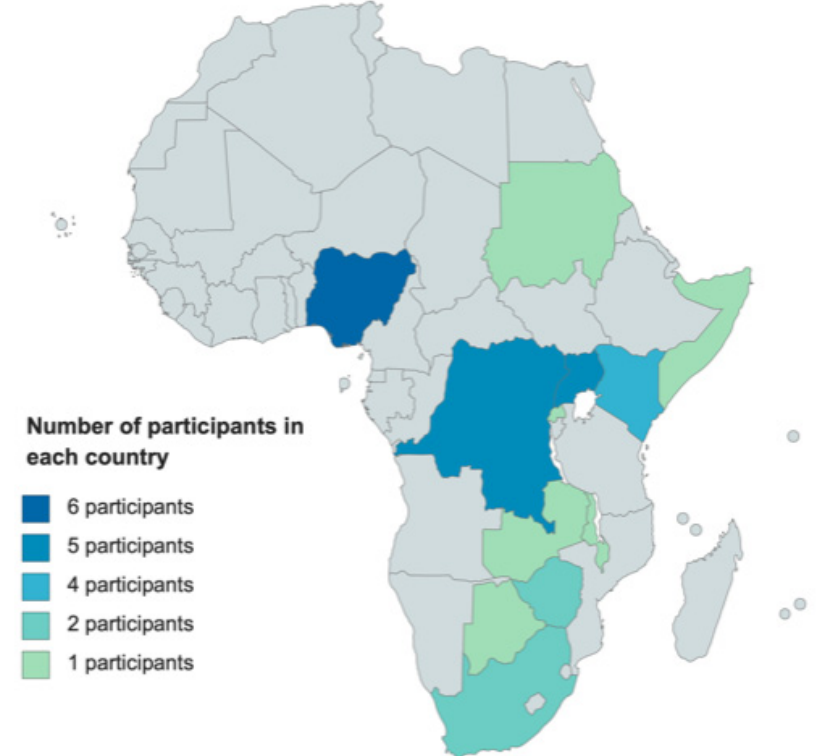
Figure 1. Geographical distribution of participants’ country of residence. Number of participants in each country: Nigeria (6), Democratic Republic of Congo (5), Uganda (5), Kenya (4), Zimbabwe (2), South Africa (2), Sudan (1), Rwanda (1), Zambia (1), Botswana (1), Malawi (1), Somaliland (1). Table 1. Participants’ demographic variables.